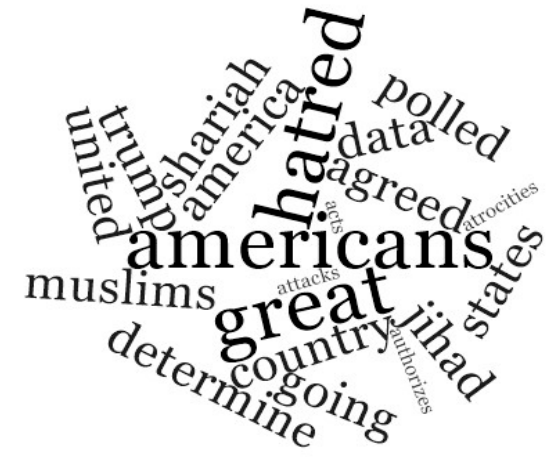
Figure 1. Most frequently used terms in the Statement